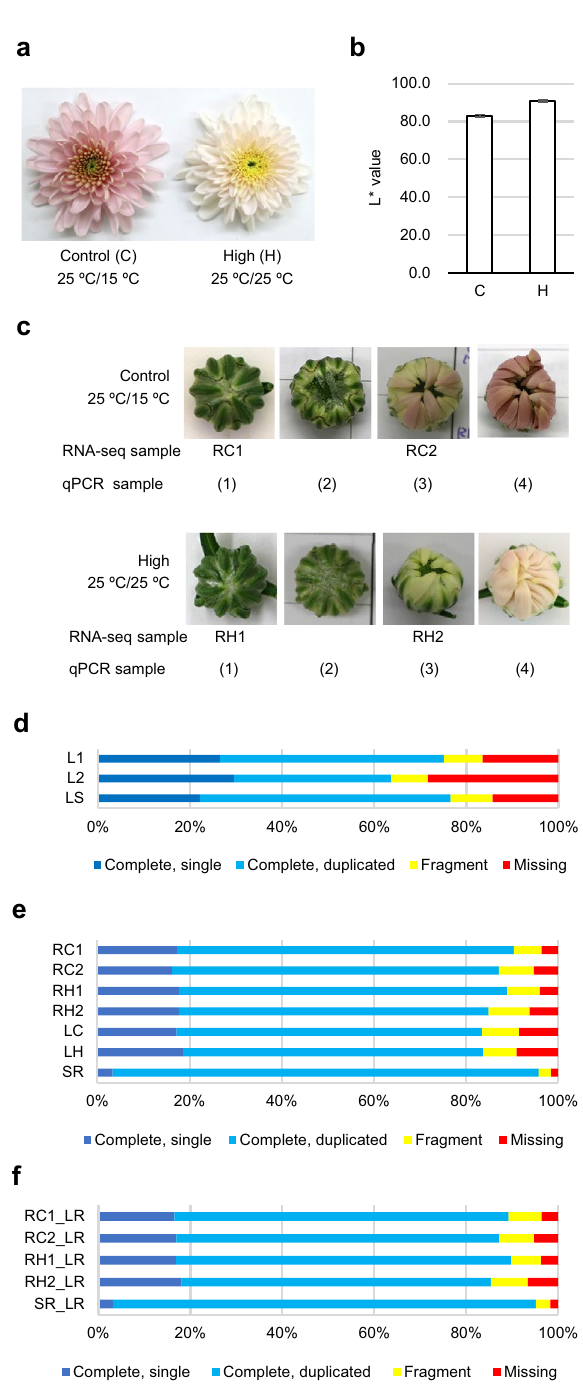
Figure 2. Samples used for SMRT-seq and RNA-seq and completeness of each dataset. ( a ) Photograph of ‘Sei Arabella’ flower grown under control (left, 25 °C/15 °C) or high nighttime temperature (right, 25 °C/25 °C) conditions. ( b ) L* value of a ‘Sei Arabella’ flower grown under control (C) or high (H) nighttime temperature conditions. Four biological replicates were used for the analysis, and error bars indicate standard deviation. L*: Perceptual lightness value of chromatic axes. ( c ) Buds and blooms, of which ray florets were used for analysis. For RNA-seq, RC1, RC2, RH1, and RH2 ray-floret samples were used. For qRT-PCR, ray florets from growth stages (1) to (4) were used. ( d – f ) Result of the BUSCO assessment of L1, L2 and LS dataset ( d ), and of RC1, RC2, RH1, RH2, LC, LH, and SR ( e ), and of RC1_LR, RC2_LR, RH1_LR, RH2_LR, and SR_LR ( f ) on embryophyta data. L1: long-read 1 dataset. L2: long-read 2 dataset. LS: long reads corrected with short reads. RC1: short-read sequences from ray florets under control conditions, stage 1. RC2: short-read sequences from ray florets under control conditions, stage 3. RH1: short-read sequences from ray florets grown at the high nighttime temperature, stage 1. RH2: short-read sequences from ray florets grown at the high nighttime temperature, stage 3. LC: short-read sequences from leaves grown under control conditions. LH: short-read sequences from leaves grown at the high nighttime temperature. SR: short- read-derived dataset including RC1, RC2, RH1, RH2, LC, and LH datasets. RC1_LR, RC2_LR, RH1_LR, and RH2_LR are short-read-derived dataset with long-read assistance and combined into